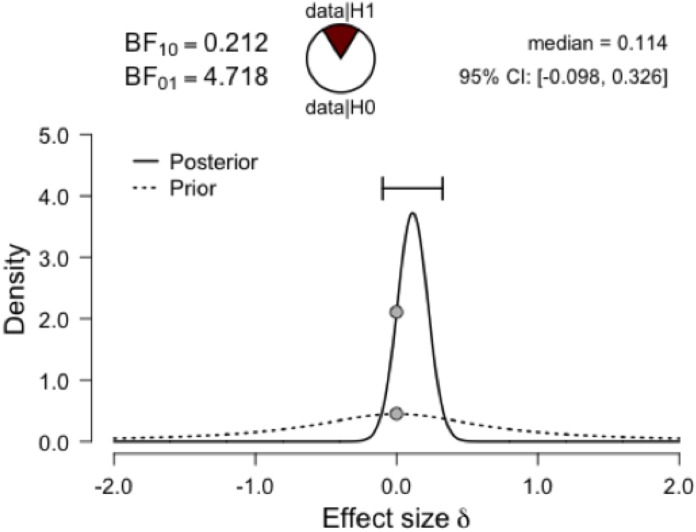
Encoding response time data relative to specific exemplar generation across experiments.The figure displays the prior and posterior distributions for effect size δ as a function of generation of specific exemplars. The sample size was limited to young adults in categorical prospective memory conditions. The BF01 and BF10 values from the Bayesian t-test both showed substantial evidence for the null hypothesis that encoding duration was similar for individuals who generated specific exemplars (n = 136; M = 21.62 sec, SD = 7.93) as those who did not generate exemplars (n = 212, M = 22.86 sec, SD = 11.76). The figures were produced using JASP software [56].